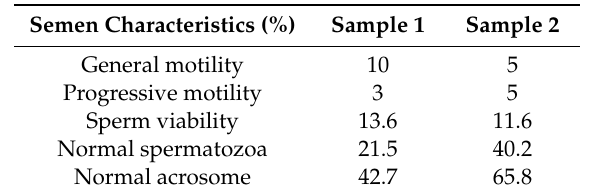
Table 5. Sperm characteristics in two di ff erent frozen-thawed semen from Leopard 1. Sample 1 was collected on 15 January 2018 and Sample 2 was collected on 28 February 2018. Both were stored for more than 2 years before thawing and evaluation. Figure 3. Photomicrograph image of Sunda clouded leopard spermatozoa under phase contrast microscopy (white arrows are pointing out the defects). ( a ) Normal spermatozoa, ( b ) bent midpiece, ( c ) coiled tail, ( d ) bent tail, ( e ) microcephalic, ( f ) bicephalic, ( g ) cytoplasmic droplet, ( h ) macrocephalic, ( i ) irregular shaped tail, ( j ) double tail, ( k ) detached head, and ( l ) shoe-hook tail.